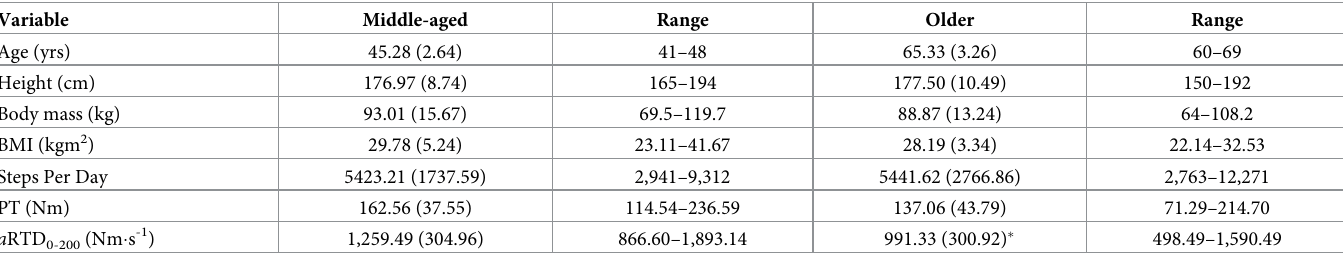
Table 1. Characteristics for the middle-aged and older